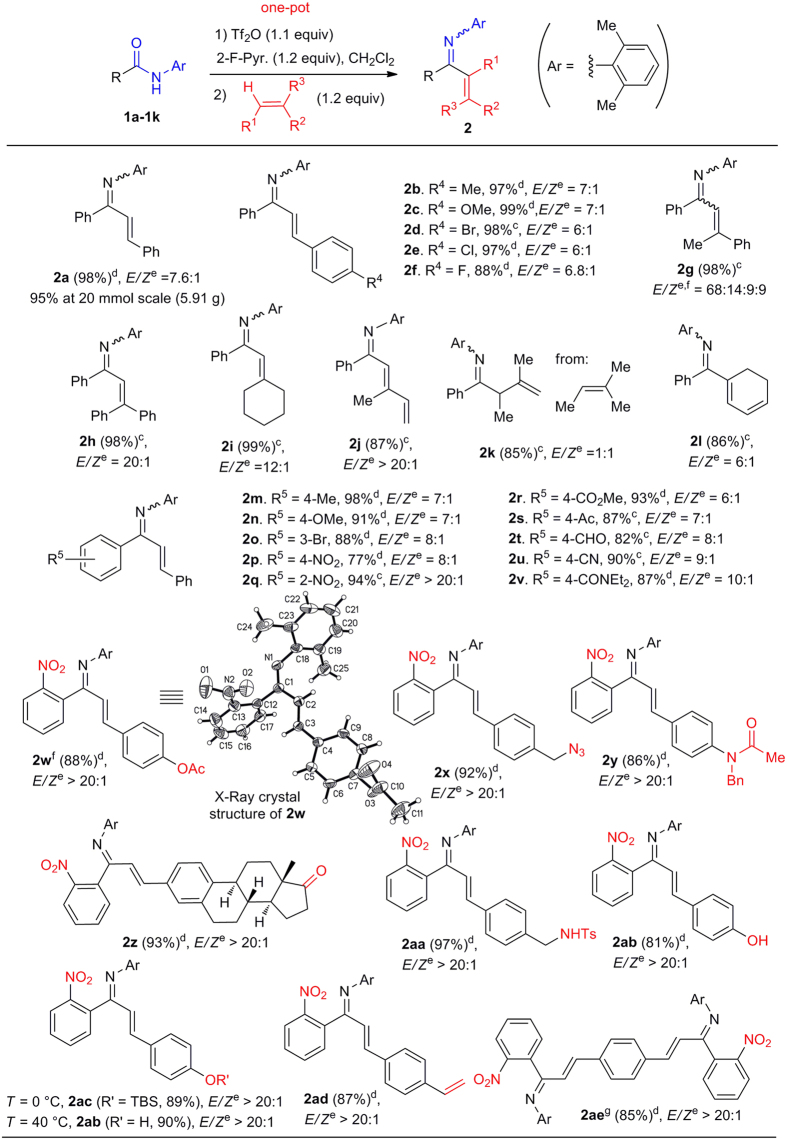
Metal-free direct coupling of N-2,6-dimethylbenzamides with alkenes to give α,β-unsaturated ketimines 2.aReaction conditions: Amide (1.0 equiv), 2-F-Pyr. (1.2 equiv), CH2Cl2 (0.25 M), then 0 °C, Tf2O (1.1 equiv), 10 min. Alkene (1.2 equiv), 2 h. bIsolated yield. cReaction ran at room temperature (rt). dReaction ran at 40 °C. eThe E/Z ratio of imines was determined by 1H NMR. fThe structure was determined by X-Ray analysis (cf. Supplementary Figure 54). g2.5 equiv of amide 1f and 1.0 equiv of 1,4-divinylbenzene were used. Ts = 4-toluenesulfonyl, TBS = tert-butyldimethylsilyl.